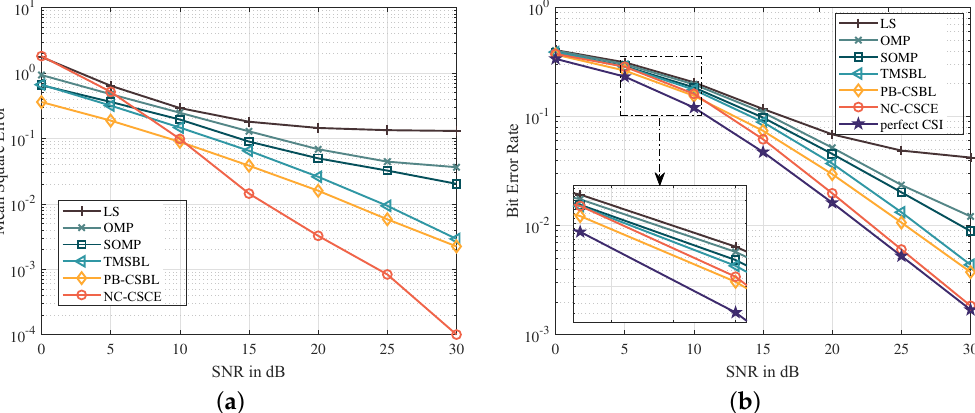
Figure 4. The comparison of MSE and BER performance based on 16-QAM constellation mapping: ( a ) the comparison of MSE performance; and ( b ) the comparison of BER